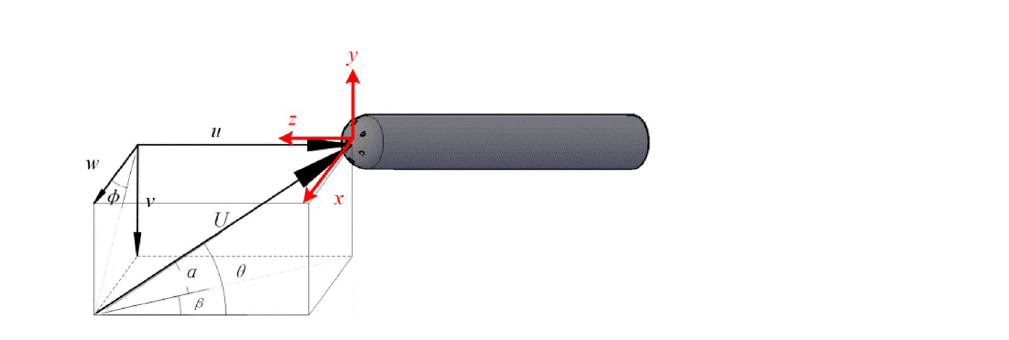
Figure 2. Cartesian coordinate system for the 7-hole